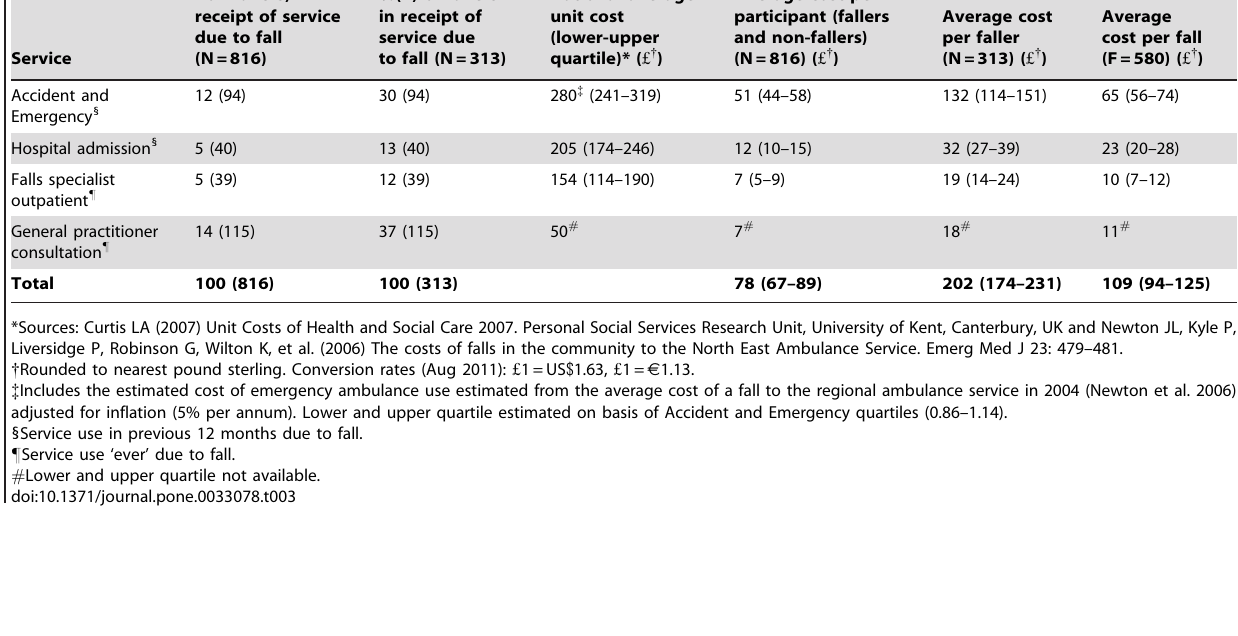
Table 4. Dizziness by type: frequency and duration of history; Fits, faints, funny turns or blackouts: number and duration of history - data reported for those experiencing symptoms in previous 12 months, by